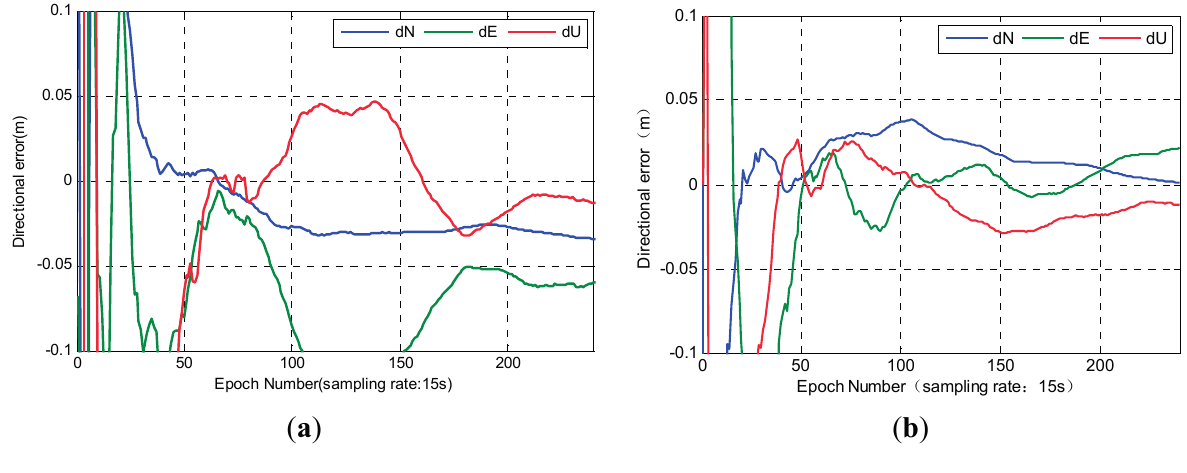
Figure 6. Results of station P175. ( a ) RSDI; ( b )